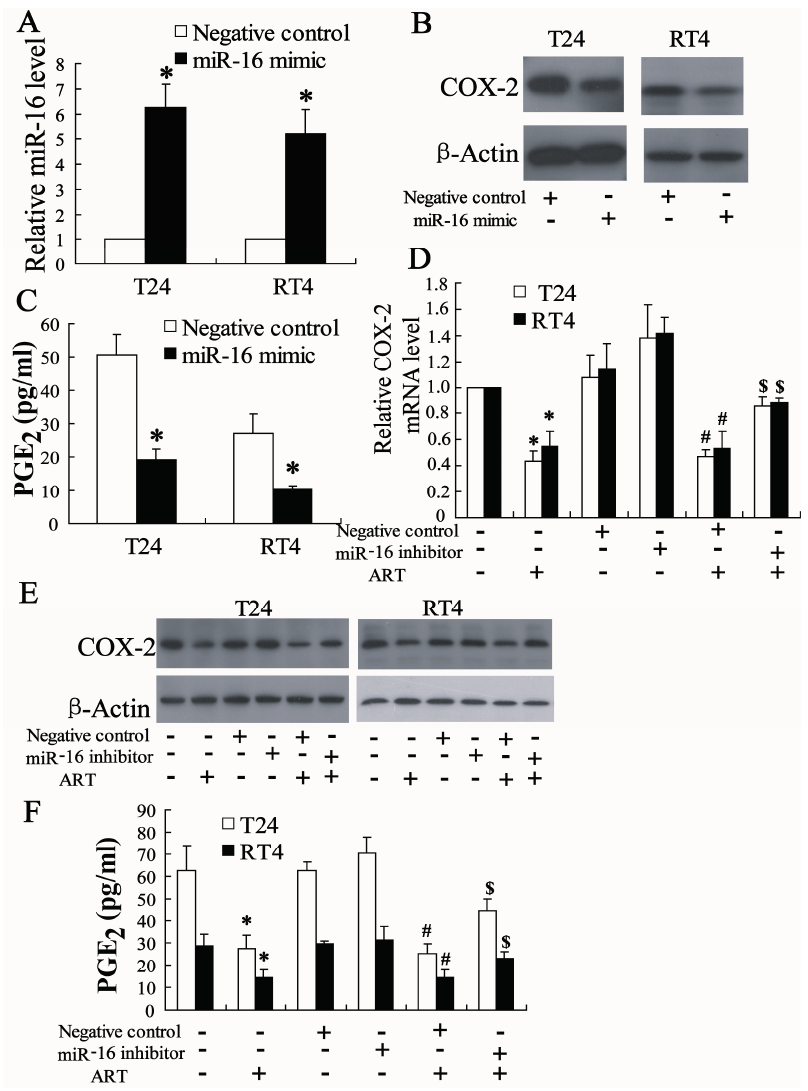
Figure 6. miR-16 is involved in ART regulation of COX-2 expression in bladder cancer cells. The level of miR-16 was detected in T24 and RT4 cells transfected with miR-16 mimic for 24 h. * p < 0.05, compared to negative control ( A ); COX-2 protein expression ( B ) in T24 and RT4 cells and PGE2 levels ( C ) in the supernatants of T24 and RT4 cells transfected with miR-16 mimic for 24 h. * p < 0.05, compared to negative control; After transfection with miR-16 inhibitor for 24 h, T24 and RT4 cells were added with ART for an additional 24 h, and then COX-2 mRNA and protein level was measured ( D , E ); After transfected with miR-16 inhibitor for 24 h, T24 and RT4 cells were added with ART for an additional 24 h, and then PGE2 levels in the supernatants were determined ( F ). * p < 0.05, compared to vehicle controls group. # p < 0.05, compared to negative control. $ p < 0.05, compared to negative control +ART (100 μ M) treated